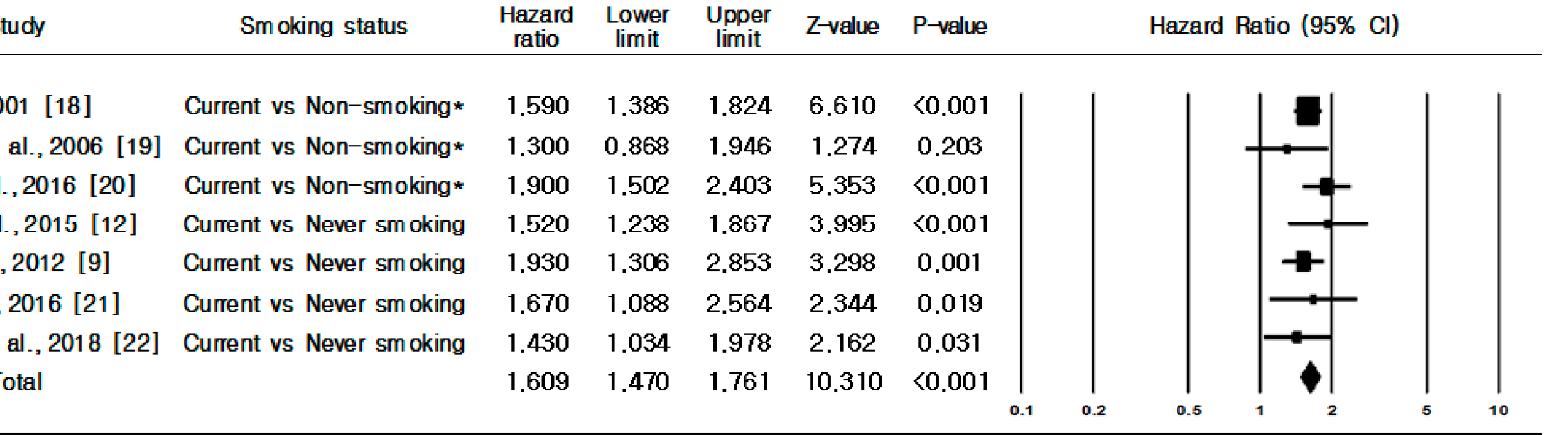
Figure 2. Heart failure incidence in current smokers versus non-smokers or never smokers. Note: * Former and never smoking.